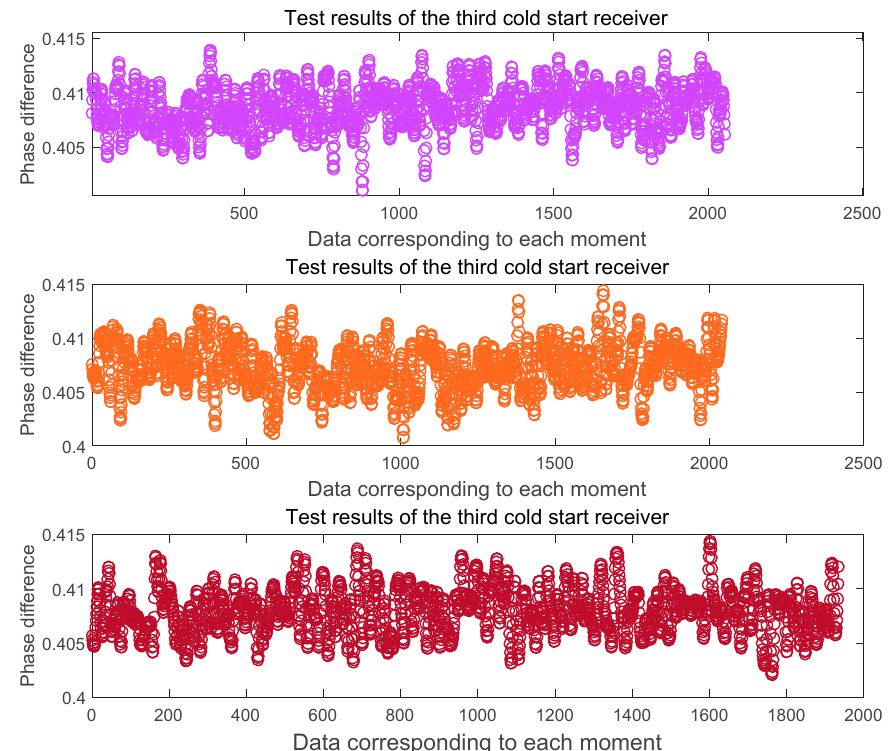
Figure 7. Phase di ff erence between L1 channels after three cold starts of the Figure 7. Phase difference between L1 channels after three cold starts of the receiver.